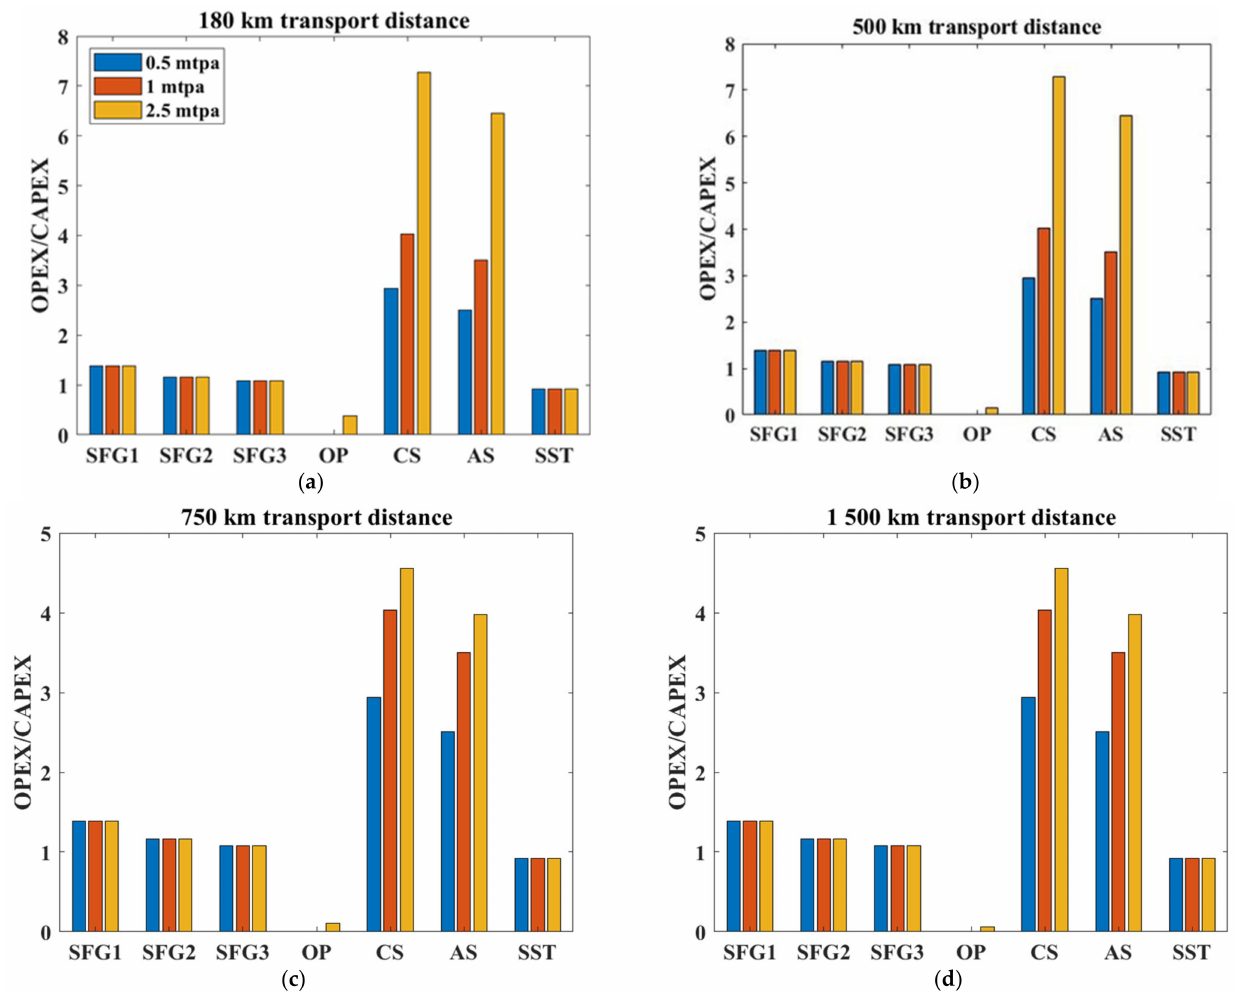
Figure 9. CAPEX/OPEX ratios for different transport distances and capacities: ( a ) 180 km; ( b ) 500 km; ( c ) 750 km; ( d ) 1500 km. Abbreviations: SFG1: subsea freight glider (469 m 3 ); SFG2: subsea freight glider (1194 m 3 ); SFG3: subsea freight glider (2430 m 3 ); OP: offshore pipeline; CS: crew ship (22,000 m 3 ); AS: autonomous ship (22,000 m 3 ); SST: subsea shuttle tanker (10,569 m 3